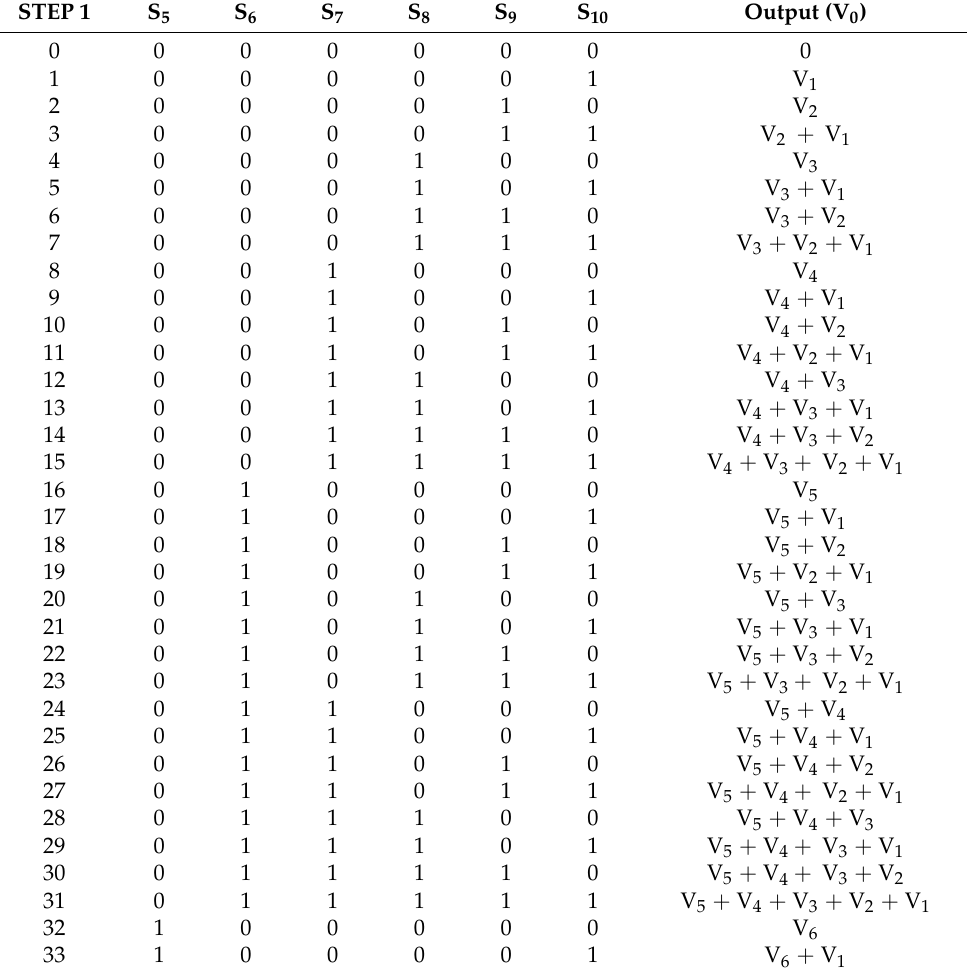
Table 1. Switching pattern of S5 to S10 in 127-level